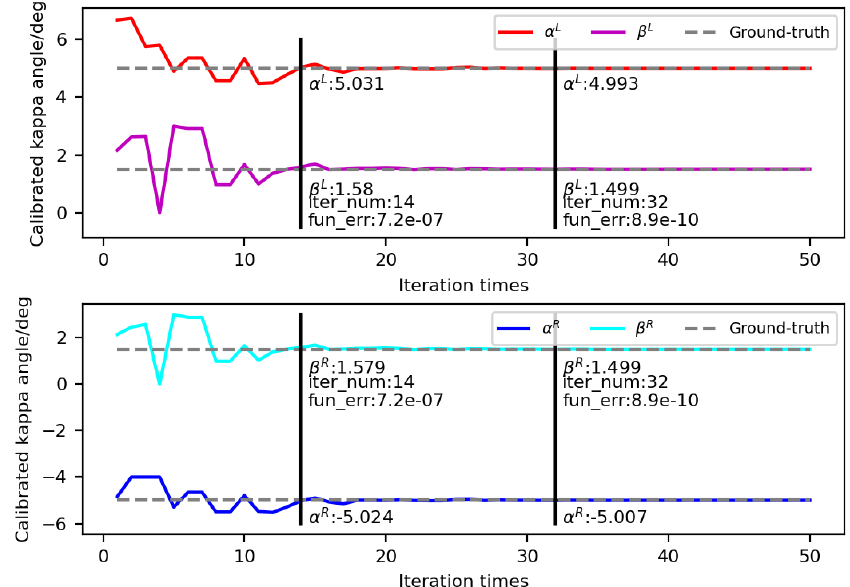
Figure 5. Iteration of kappa-angle calibration in the third